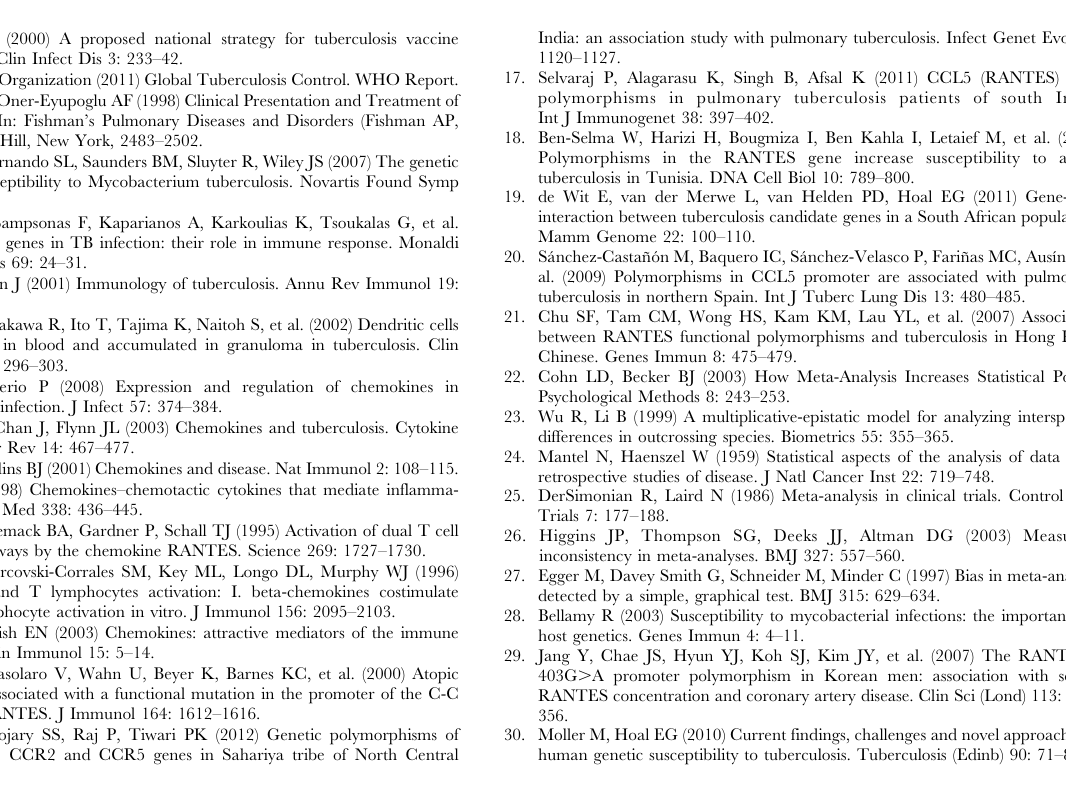
Figure S1 PRISMA 2009 Flow Diagram.